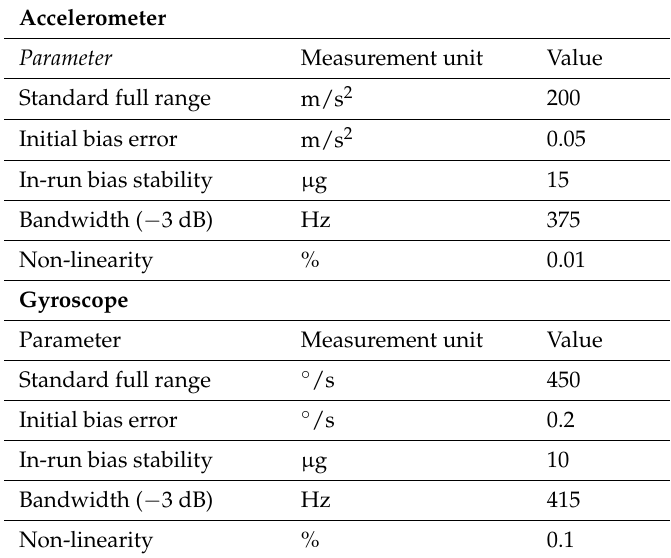
Table 2. Technical specificationsof the sensor used in the data collection: Xsens with Model